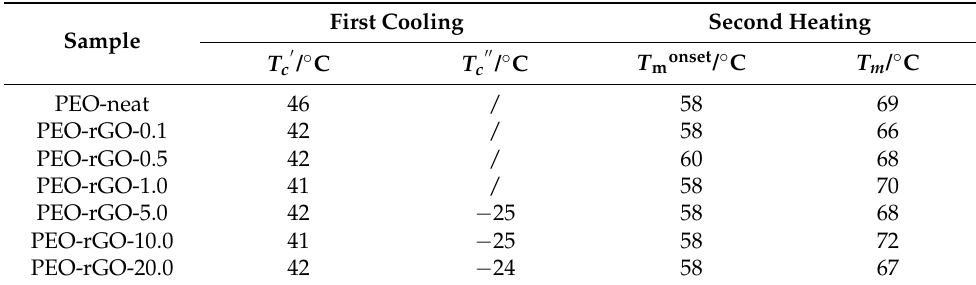
Table 2. Crystallization and melting temperatures for PEO-neat and rGO-modified samples.